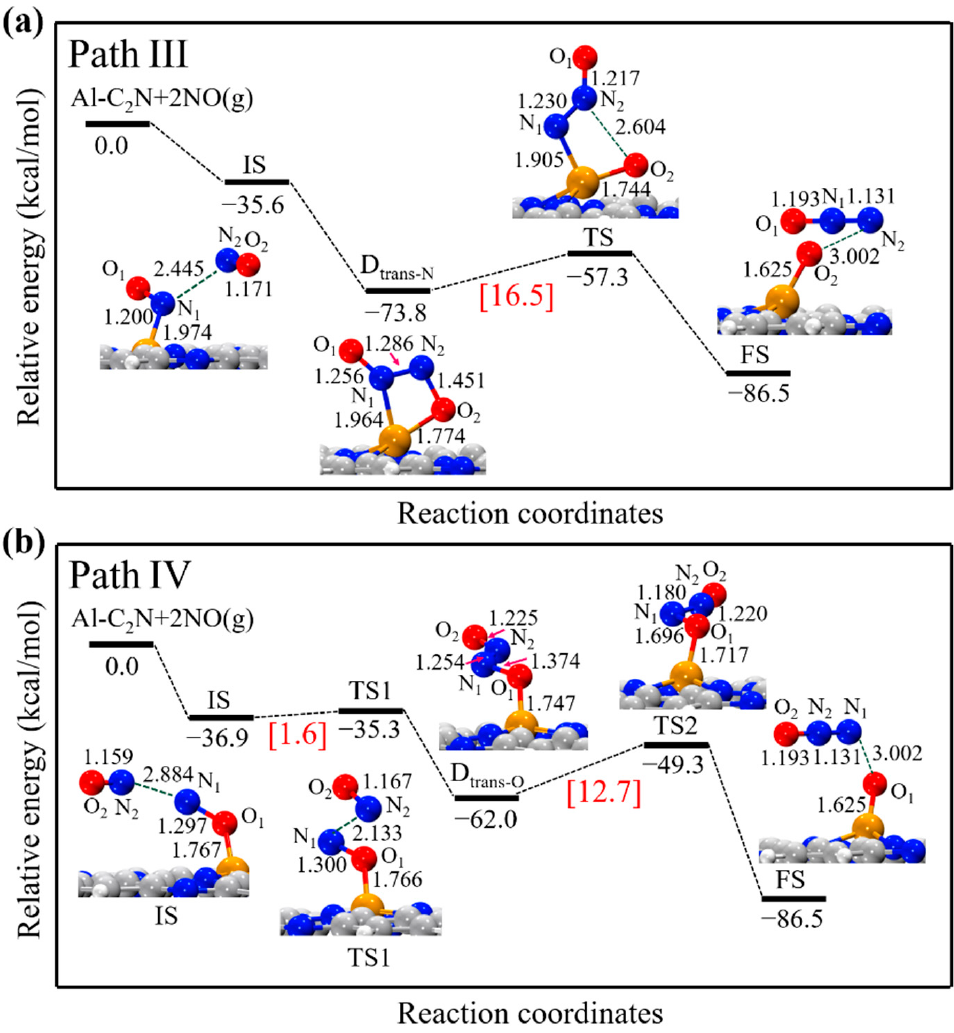
Figure 6. The energy profiles and corresponding structures of the ( a ) D trans-N and ( b ) D trans-O dimer reduction process on Al-C 2 N. All bond lengths are in Å.